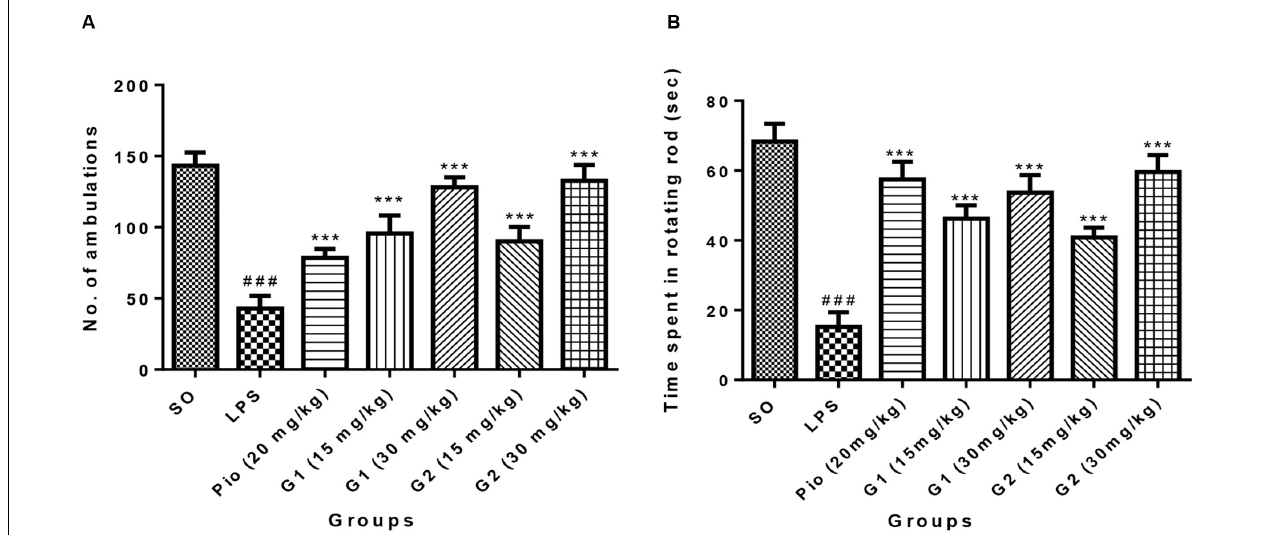
FIGURE 4 | Effect of novel glitazones on (A) actophotometer test and (B) rotarod test of ICV-LPS-administered rats. Values are expressed as mean ± SEM. Statistical significance was determined by one-way ANOVA followed by Bonferroni’s multiple comparison tests. Superscript ### denotes p < 0.001 vs. SO and *** denotes p < 0.001 vs. LPS. SO, sham operated; LPS, lipopolysaccharide; Pio, pioglitazone; G,